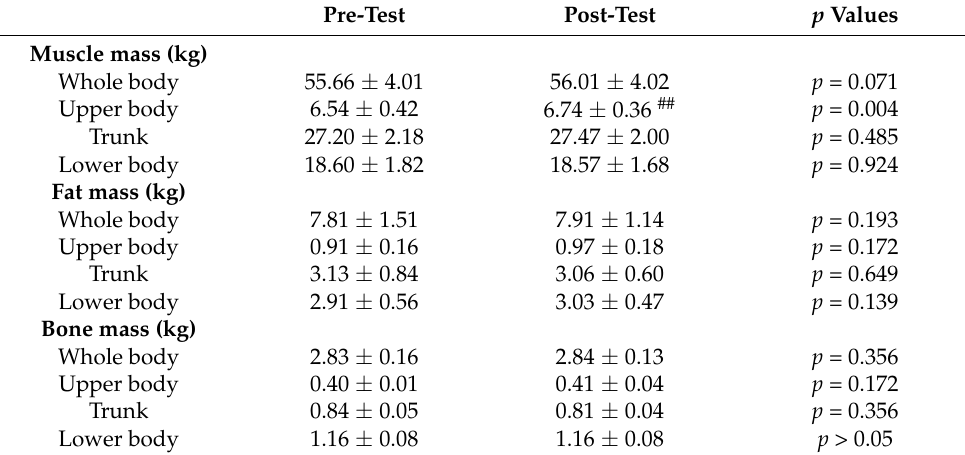
Table 5. Changes in Body Composition after 4-weeks Moderate Altitude